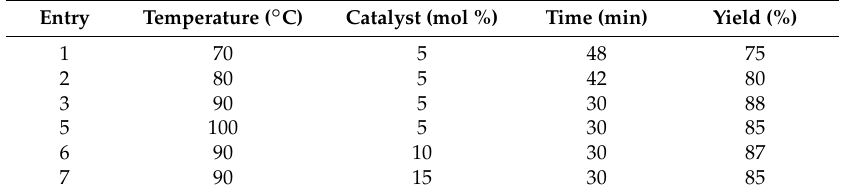
Table 3. Effect of different reaction conditions on [Et 3 NH][HSO 4 ] catalyzed synthesis of 6a .